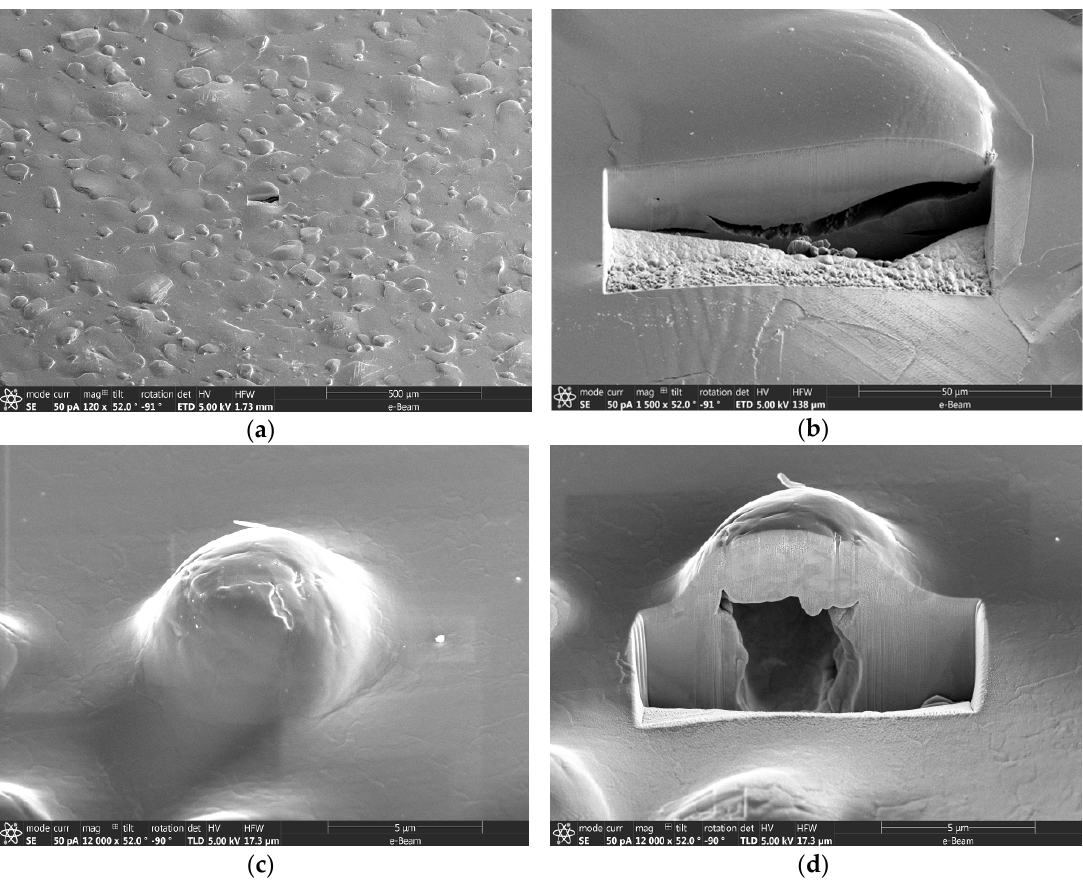
Figure 14. Images of the surface of 99.99996% coarse copper, which were taken on a FIB-SEM Helios G3 UC focused ion beam electron microscope. In ( a , b , d ), a blister specially cut by an ion beam is seen; ( c ) showed the blister before it was cut.